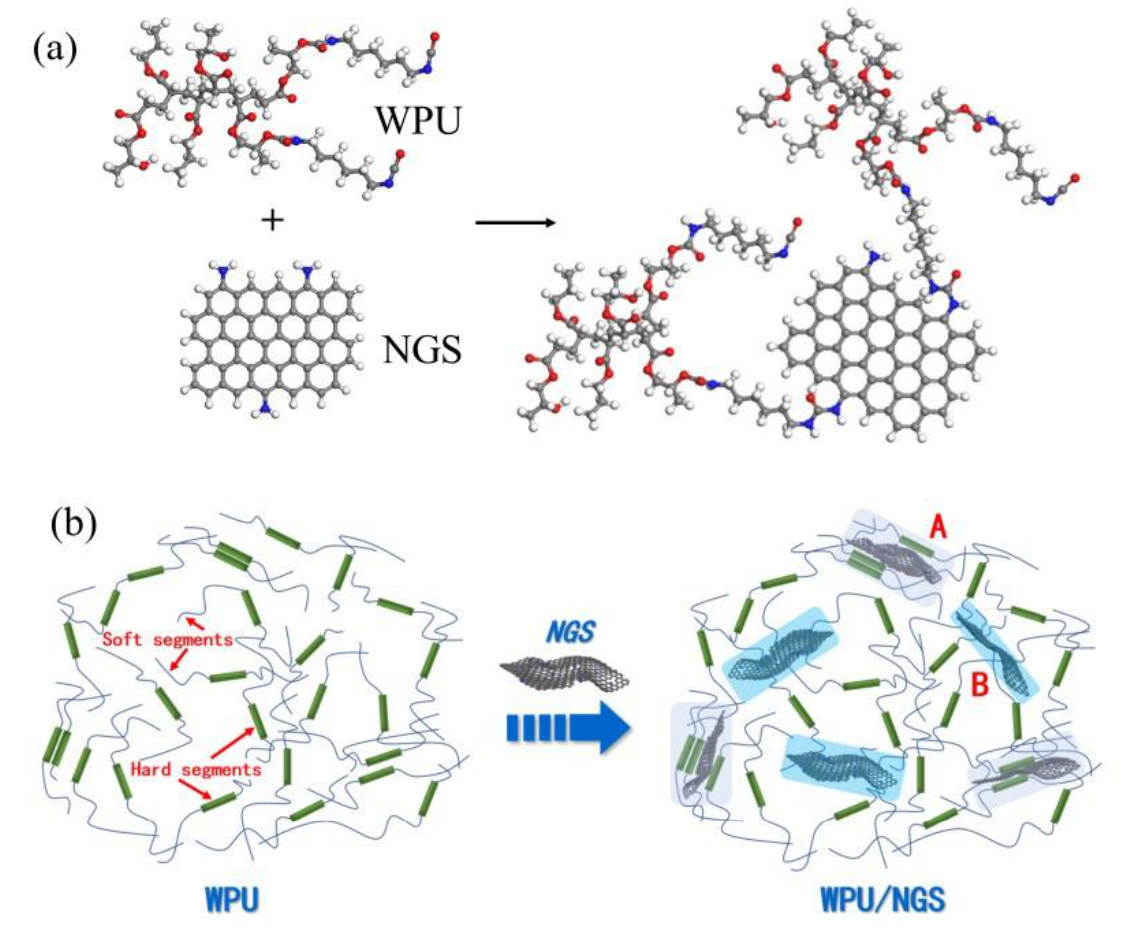
Figure 8. ( a ) The chemical reaction between WPU and NGS; ( b ) the schematic of interfacial interaction of polyurethane matrix with NGS: A stands for the interaction between hard segments and NGS, B stands for the crosslinking of soft segments with NGS.